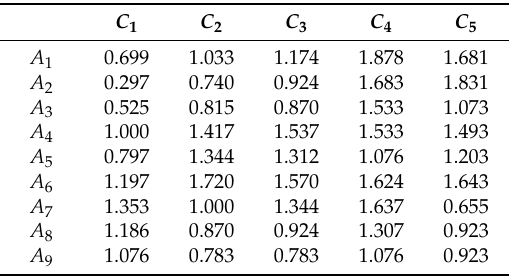
Table 5. Approach-index matrix in real